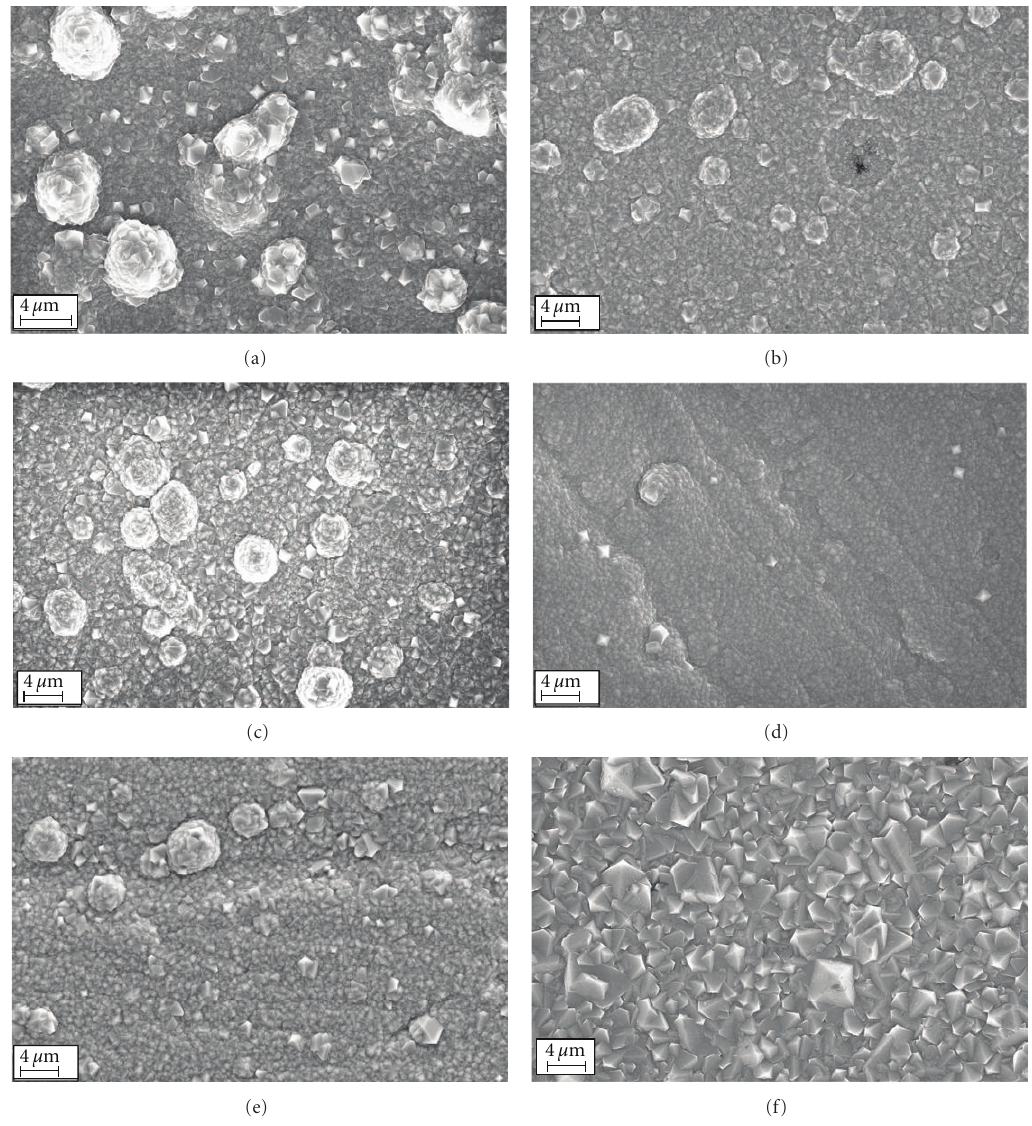
Figure 6: SEM micrographs of diamond films grown by HFCVD on di ff erent interlayered WC-Co samples: (a) 3h CVD on TiN a, (b) 3 h CVD on TiC, (c) 3h CVD on Ti(C, N), (d) 3 h CVD on CrC, (e) 3 h CVD on CrN, and (f) 9h CVD on